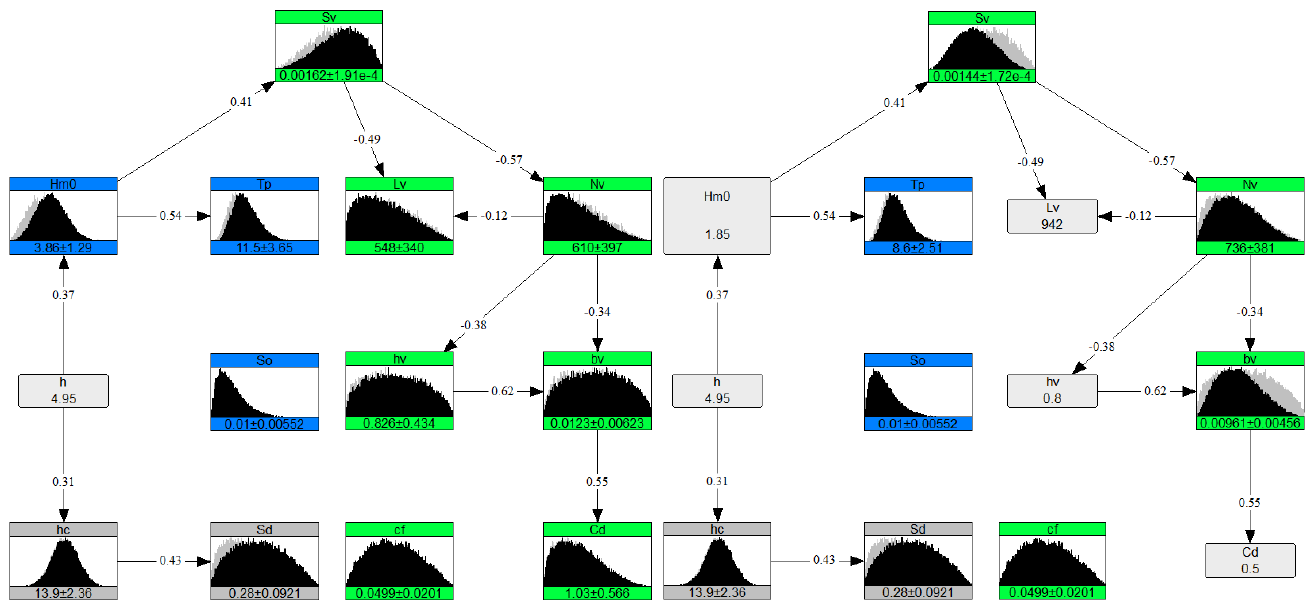
Figure 13. Case application using the conditions measured by